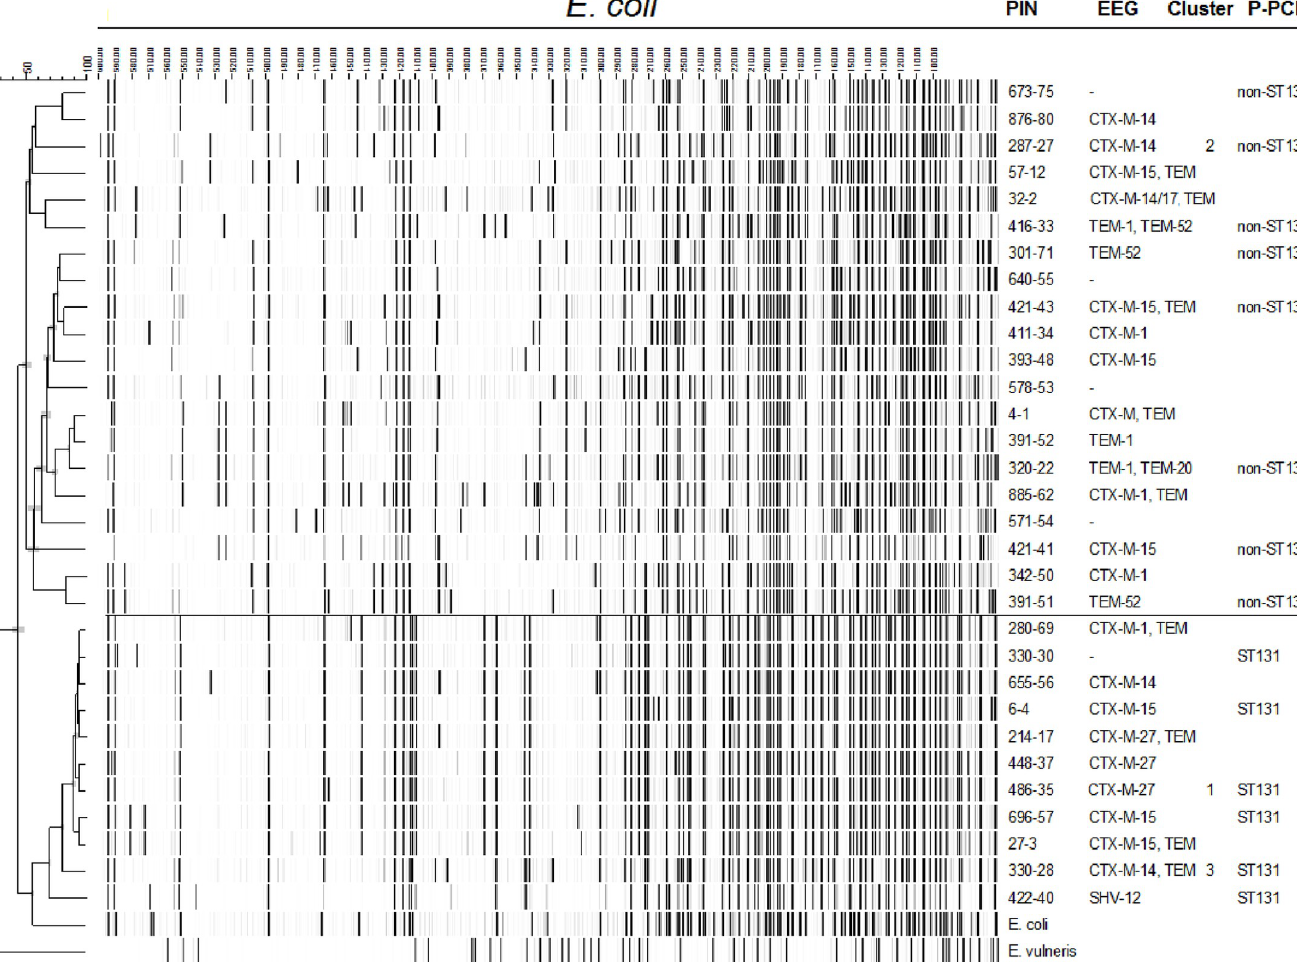
Fig 1. AFLP-results of all E . Coli isolates with one representative isolate per cluster. Abbreviations: PIN = Patient Identification Number; EEG = ESBL Encoding Gene; P-PCR = Phylogroup defining Polymerase Chain